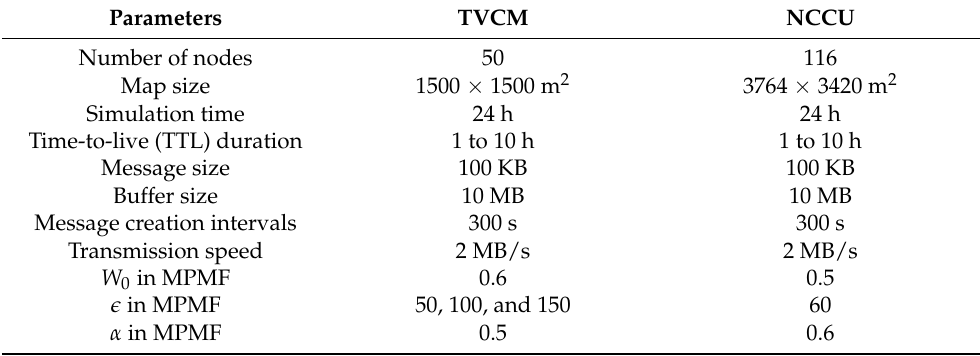
Table 1. Simulation